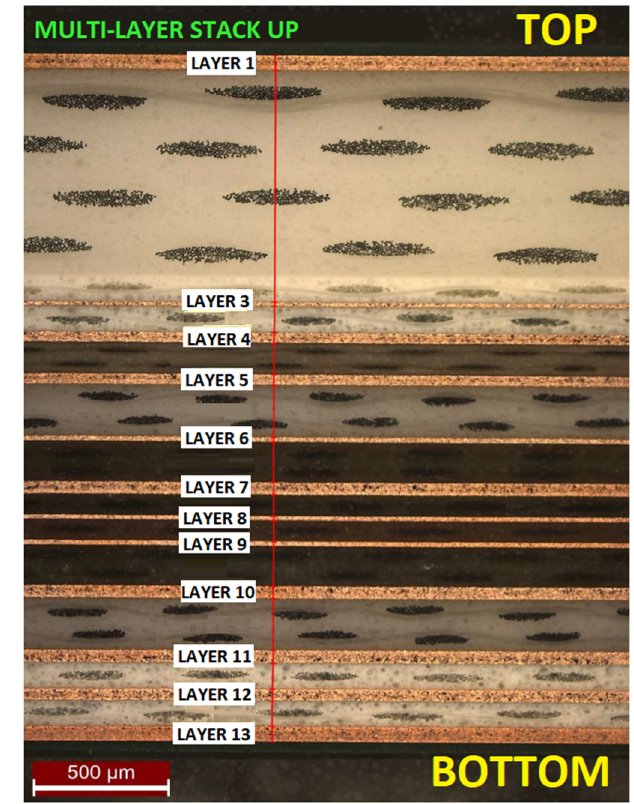
Figure 3. Transversal cut of the multi-layer PCB showing the stack-up structure.